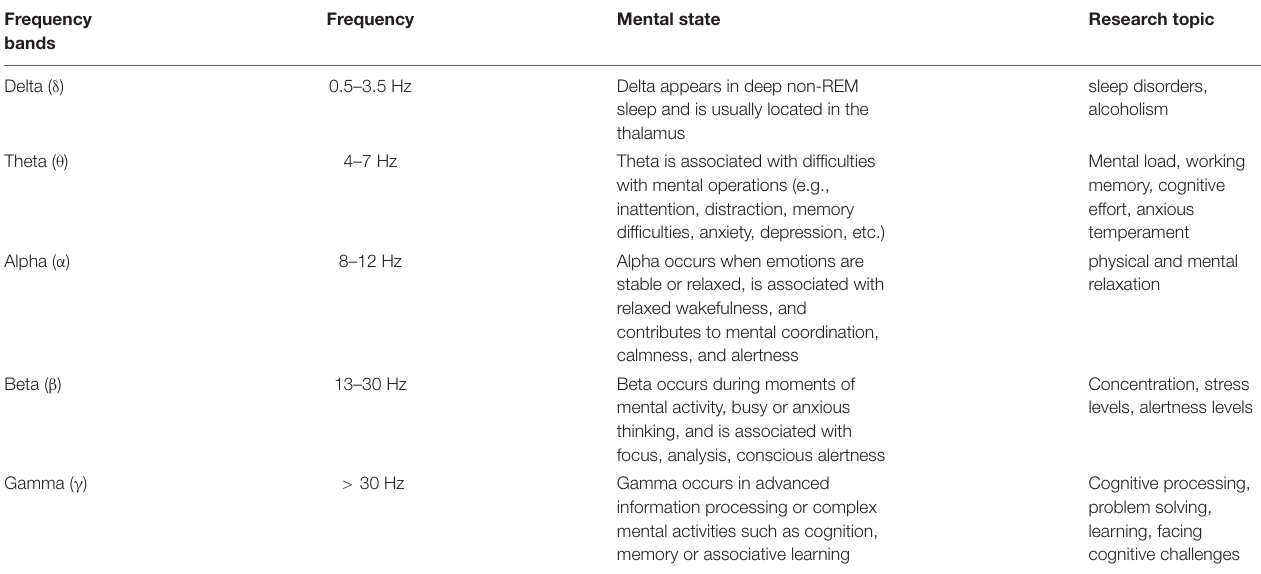
FIGURE 9 | Keywords co-occurrence network of ET in building construction. TABLE 4 | Specific information on EEG frequency